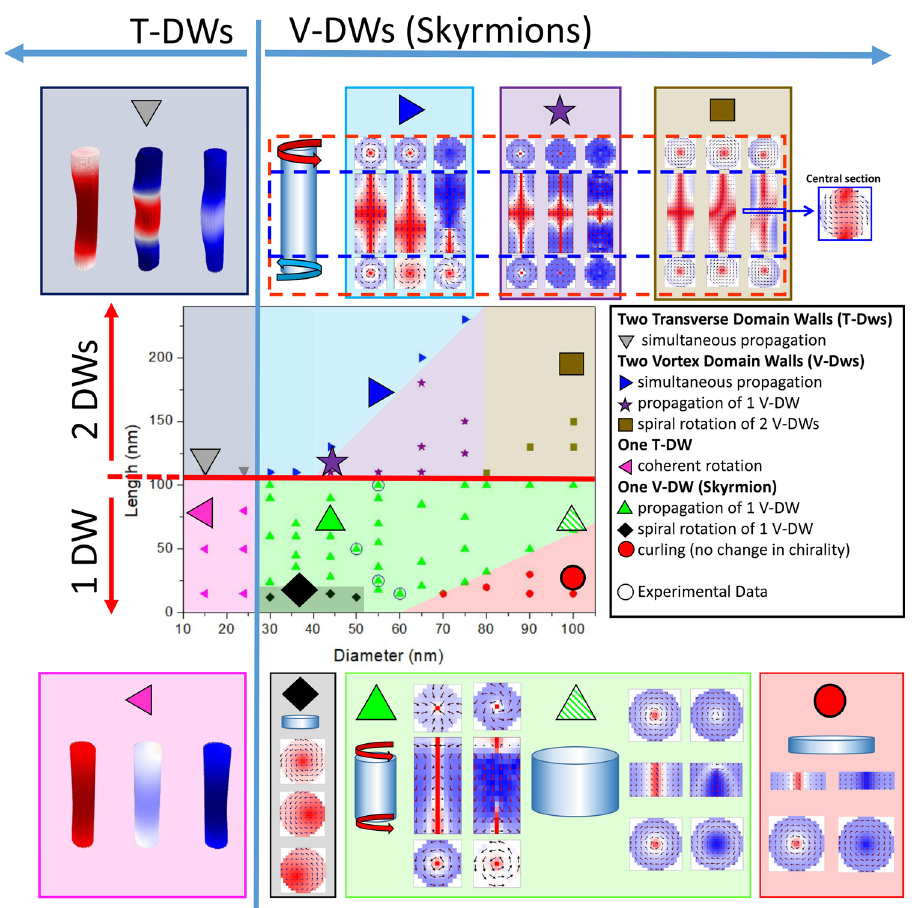
Figure 5. Phase diagram of the magnetization reversal modes in individual Ni nanowires with different lengths and diameters, when applying the magnetic field along the nanowire’s length (parallel direction). Insets show selected cross-sectional representations of the magnetic configuration during reversal (using the same color scale as in Fig.